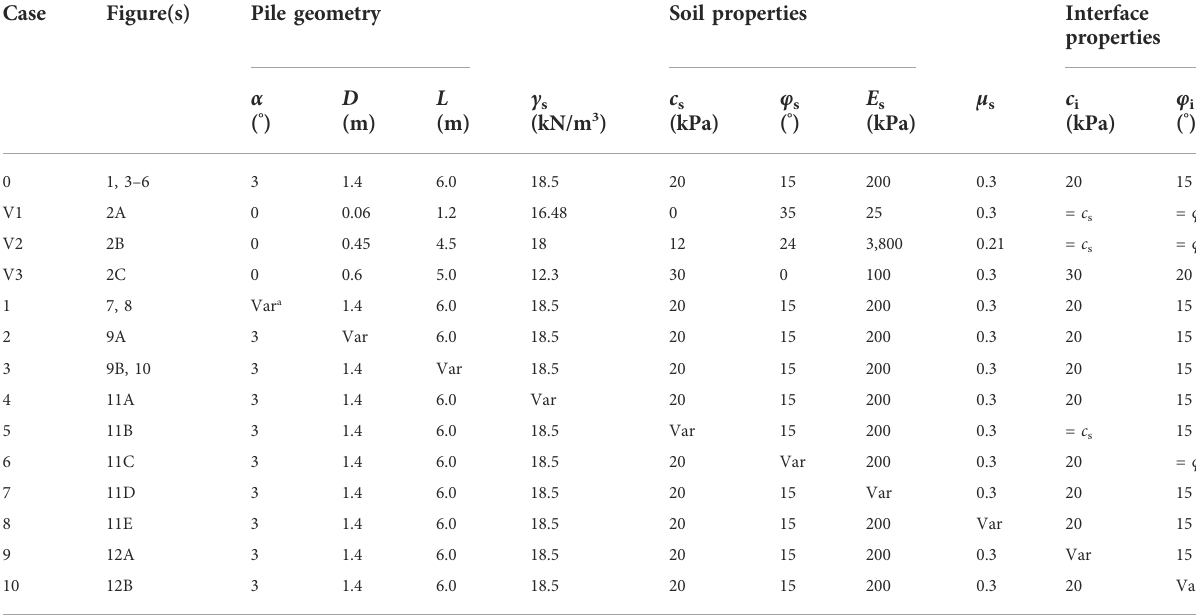
Pile geometry Soil properties Interface